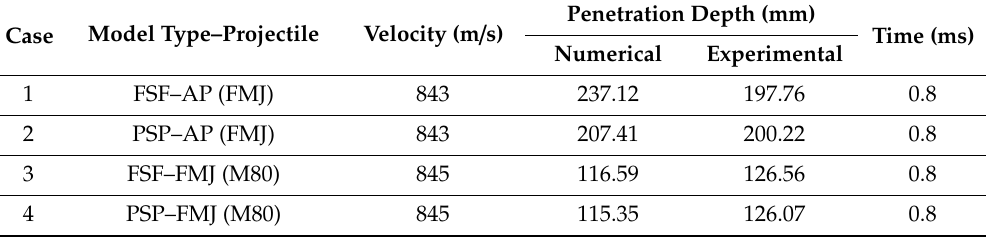
Table 5. Comparison of numerical and experimental results for each case.